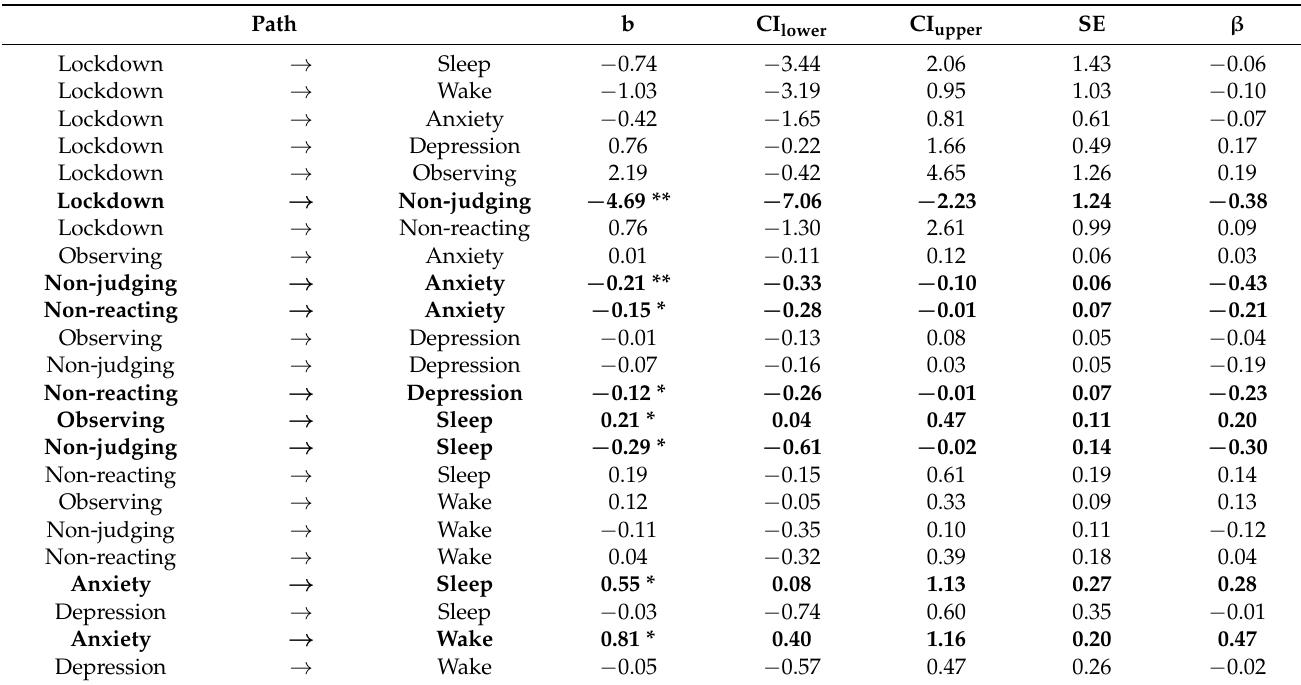
Table 3. SEM estimated coefficients for model 2.